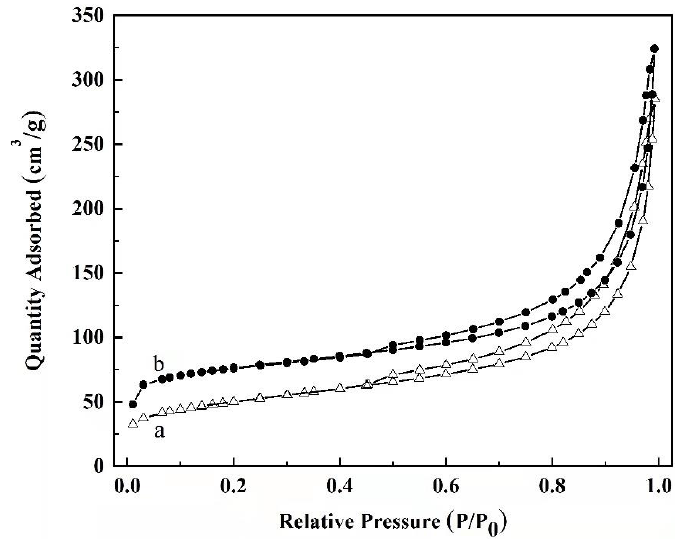
Figure 4. Nitrogen adsorption–desorption isotherm for RGO (a) and RGO-SiO 2